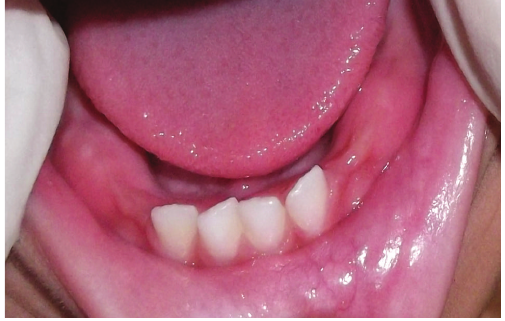
Figure 4: 1 week postoperatively showing normal